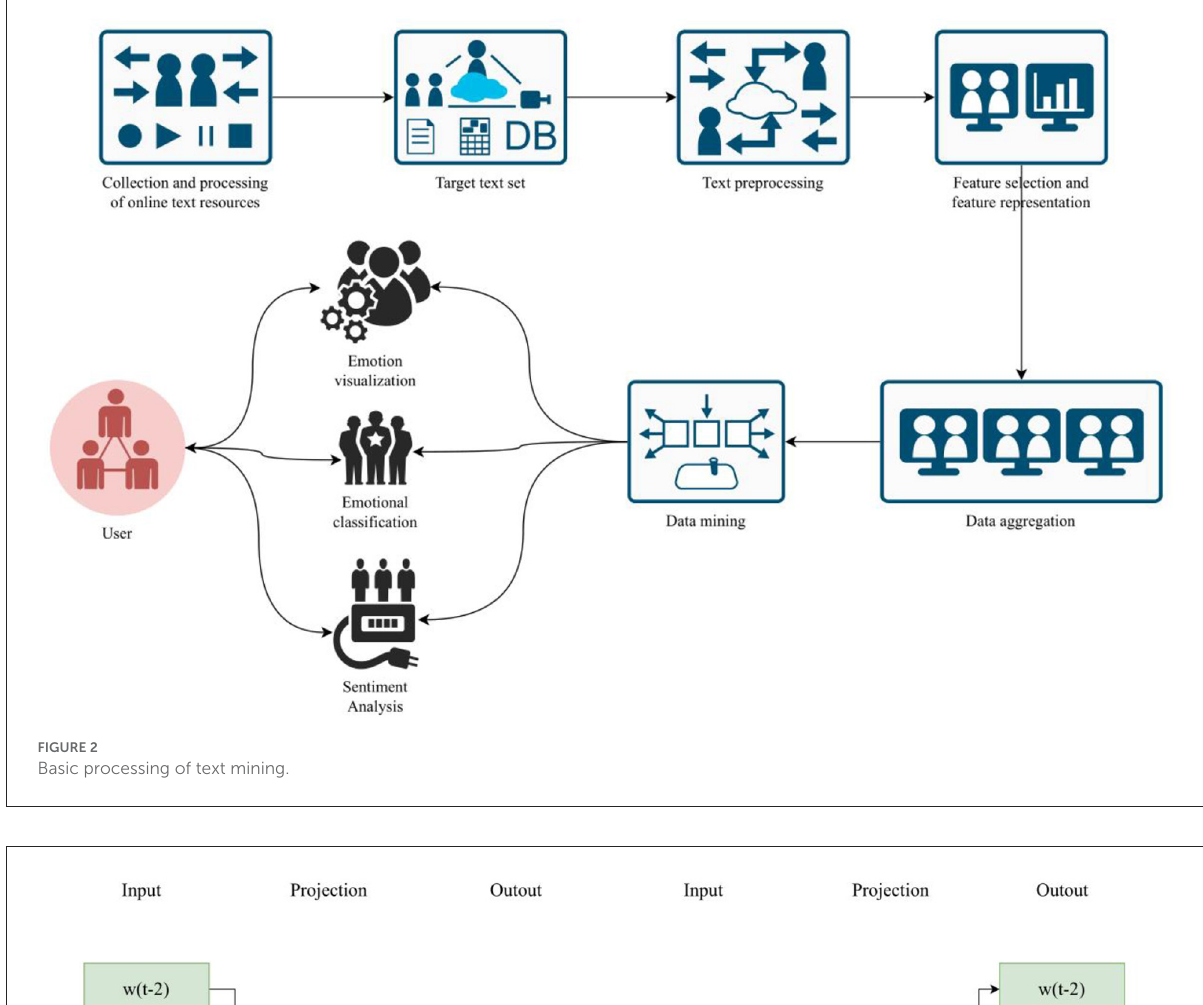
FIGURE2 Basic processing of text mining.